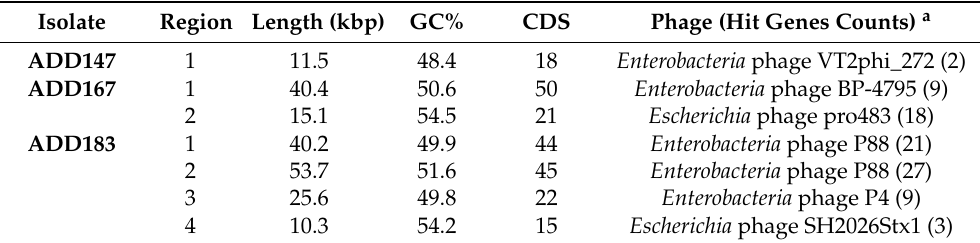
Table 3. Distribution of intact prophage regions of antibiotic-resistant E. coli isolates from surface water of agricultural drainage in northwestern